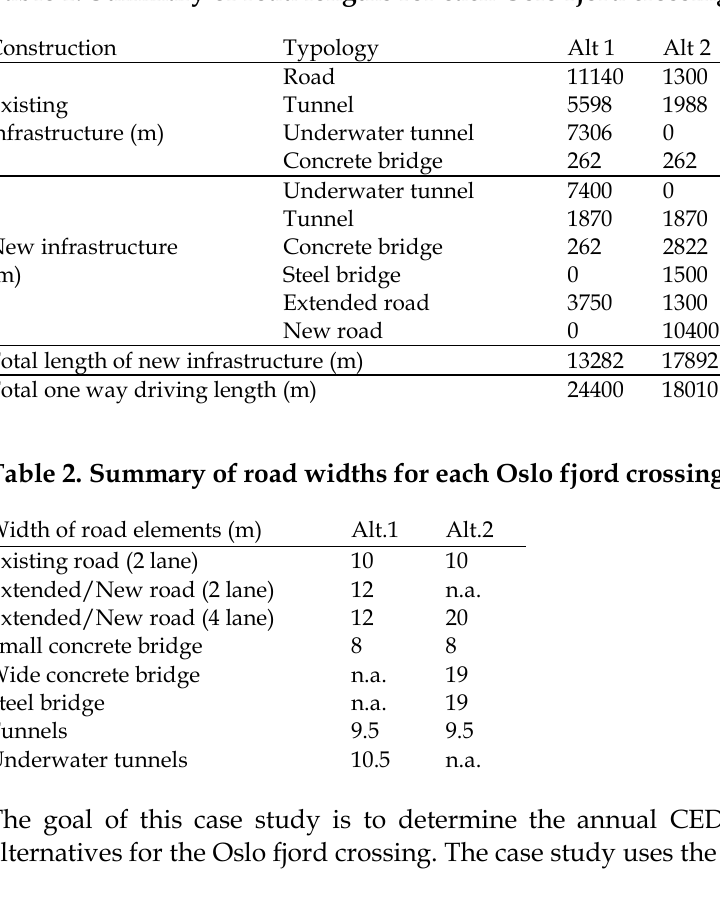
Table 1. Summary of road lengths for each Oslo fjord crossing alternative